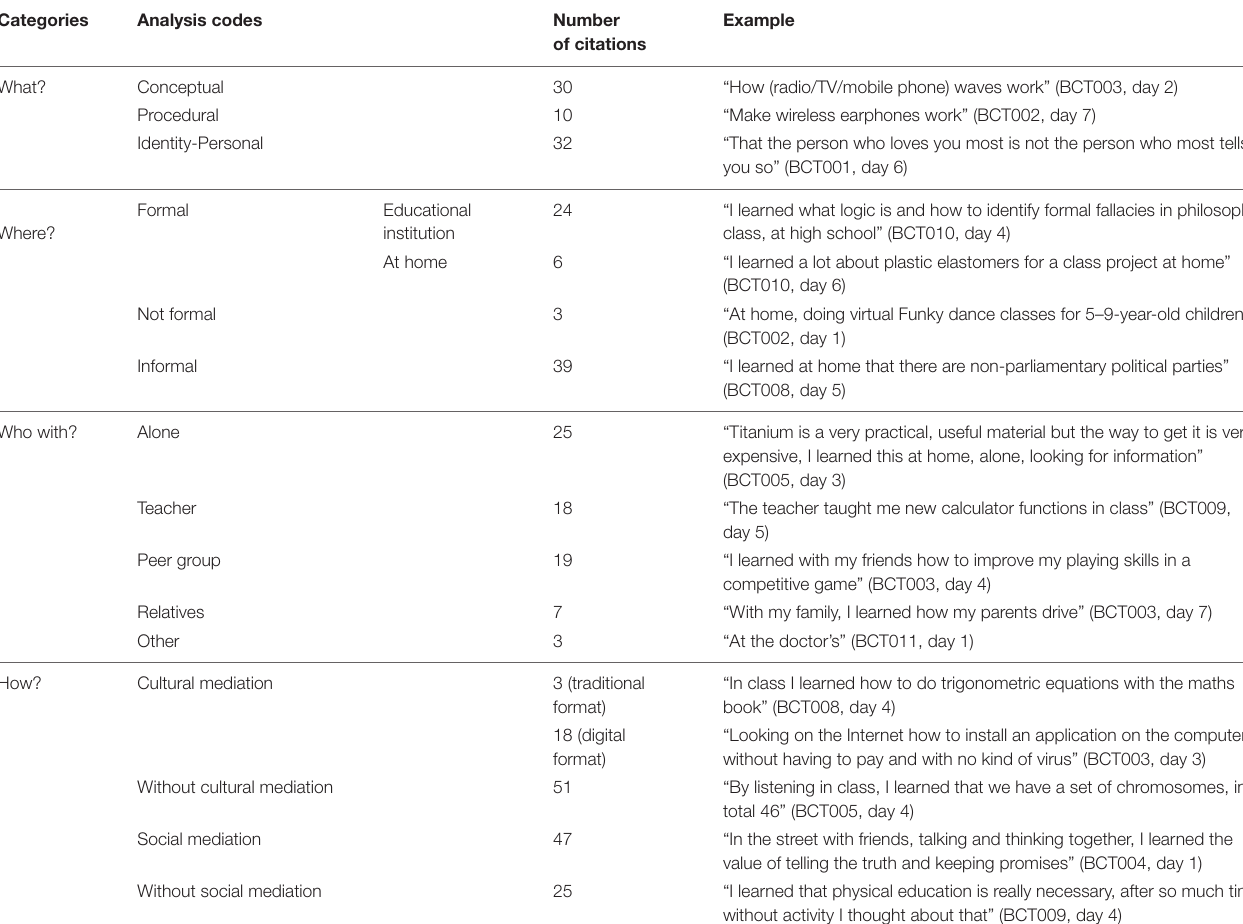
TABLE 4 | Citations associated with the different categories and analysis codes. Analysis